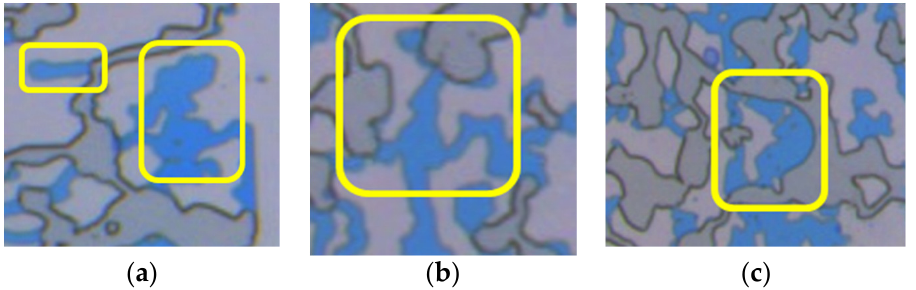
Figure 7. Causes analysis of wetting phase retention in porous media. ( a ) Retained water phase in dead volume; ( b ) Variable-diameter capillary pressure; ( c ) Adsorption retention of the surface wetting phase.